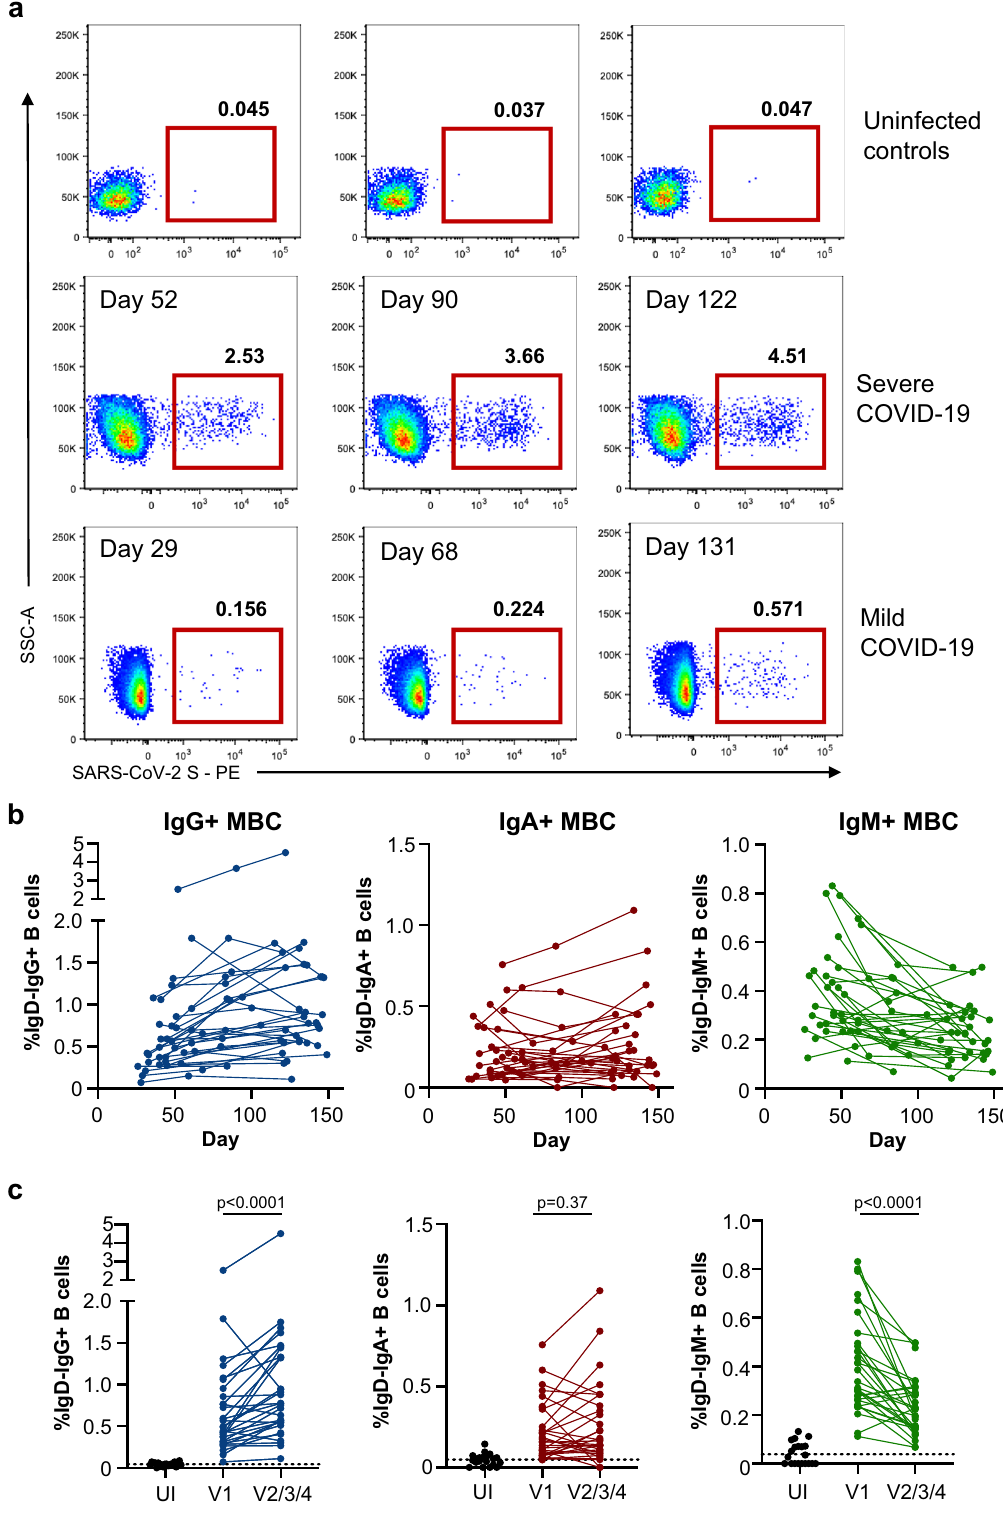
Fig. 3 Quanti fi cation of S-speci fi c memory B cell responses. a Staining class-switched B cells (CD19 + IgD-) with SARS-CoV-2 spike probes allows the tracking of antigen-speci fi c cells in participants previously infected with SARS-CoV-2, shown relative to uninfected controls. Longitudinal plots from a single individual with severe infection or a single individual with mild infection are shown. b Frequencies of S-speci fi c IgG + , IgA + , or IgM + memory B cells as a proportion of CD19 + CD20 + IgD − B cells in PBMC samples were assessed longitudinally ( n = 31 participants). c Comparison of S-speci fi c IgG + , IgA + , or IgM + memory B cell frequencies at the earliest and latest timepoint available for each individual ( n = 31). Median background in uninfected (UI) controls ( n = 20) is indicated. Statistics assessed by two-tailed Wilcoxon test. Source data are provided as a Source Data fi